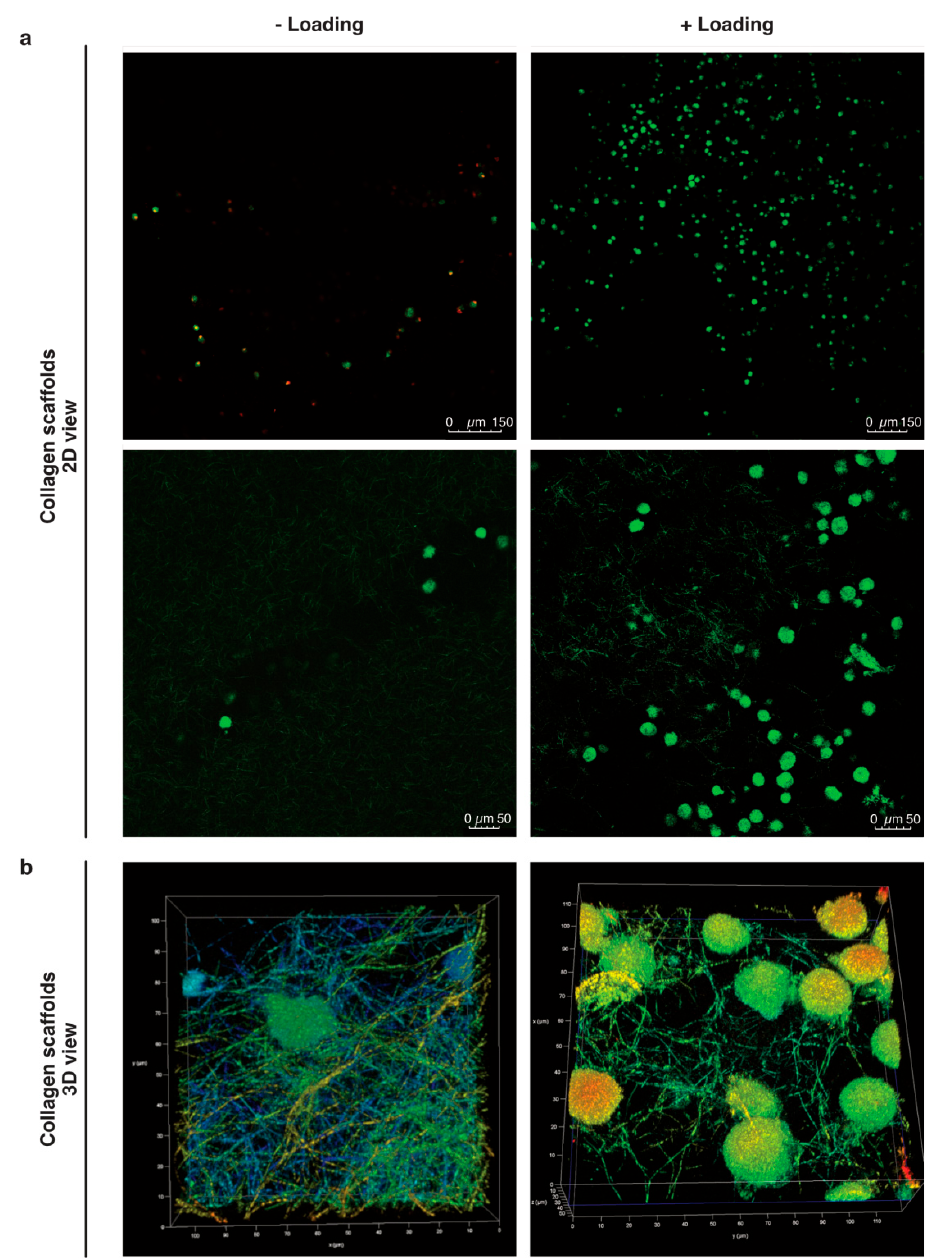
Figure 2. Mobilized cells into col-I sca ff olds after mechanical stimulation. ( a ) The cells in the sca ff olds were visualized by confocal microscopy after 24 h with or without mechanical stimulation. Viable cells are stained with C-AM (calcein-A, green) and non-viable with EthD-1 (Ethidium homodimer-1, red). ( b ) 3D images in 20 × magnification plus 5X digital zoom of cells in loaded and unloaded col-I sca ff olds. Pseudo-colors are used in ( b ) for a better visualization of cells within the collagen network.